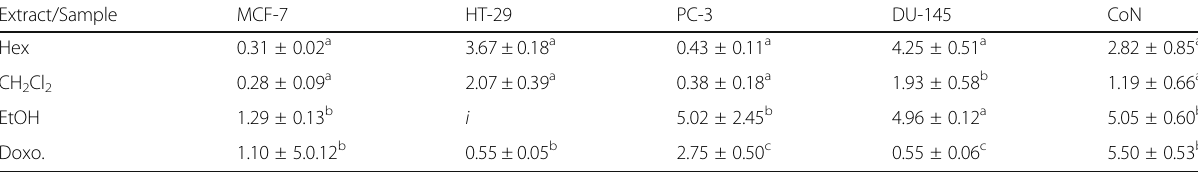
Table 4 Cytotoxic effect of E. chilensis extracts (IC 50 μ g / mL) for different cell lines compared to an antineoplastic drug Extract/Sample